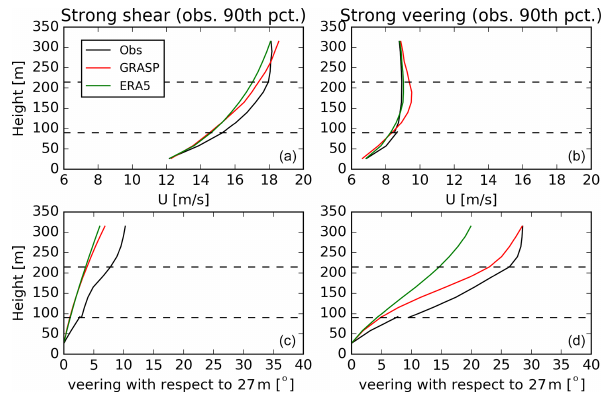
Figure 6. Comparison of the 90th percentile strongest shear (a, c) and veer (b, d) conditions from observations, ERA5 and